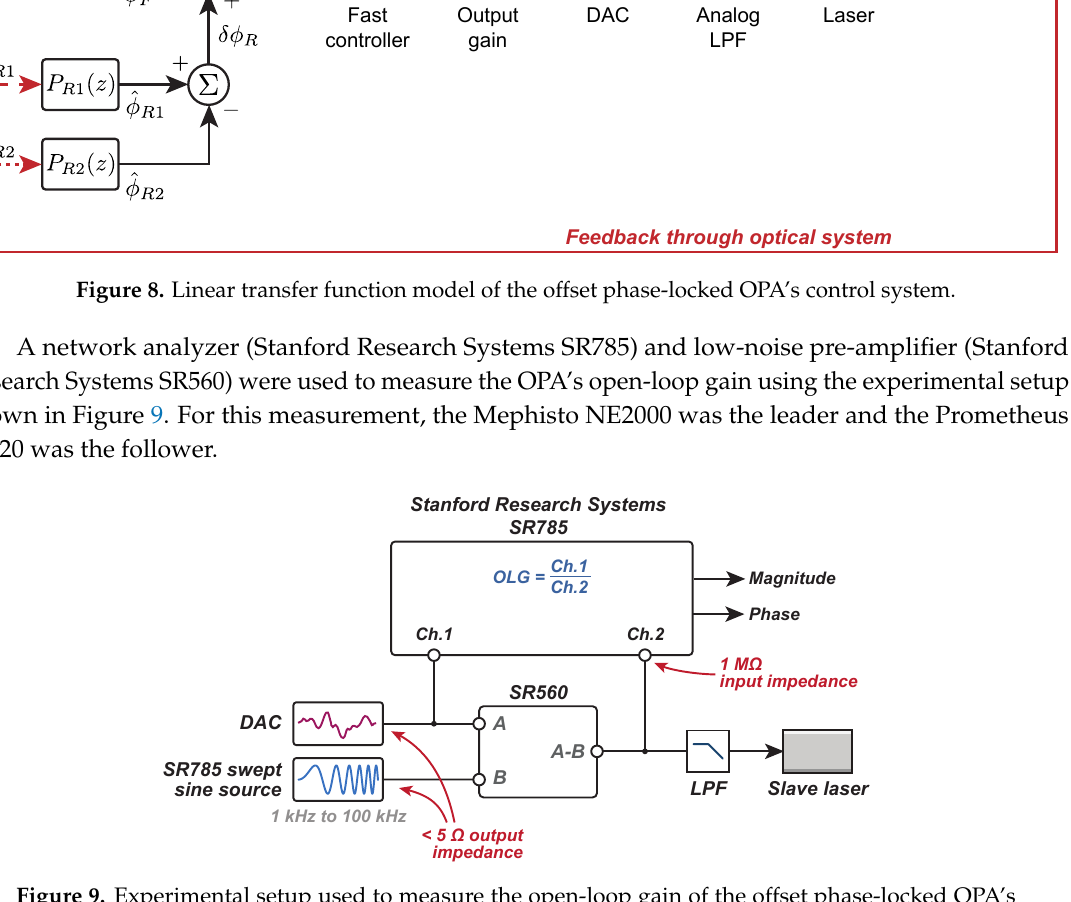
Figure 9. Experimental setup used to measure the open-loop gain of the offset phase-locked OPA’s control